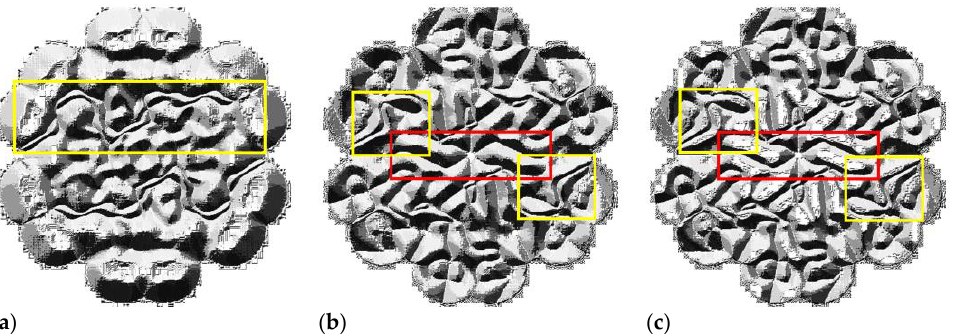
Figure 7. The contrast between Uniform Pattern LBP feature extraction based on the PM, the SM, and the DSM loaded with the same pistons: ( a ) the LBP feature of the PM; ( b ) the LBP feature of the SM; ( c ) the LBP feature of the DSM.